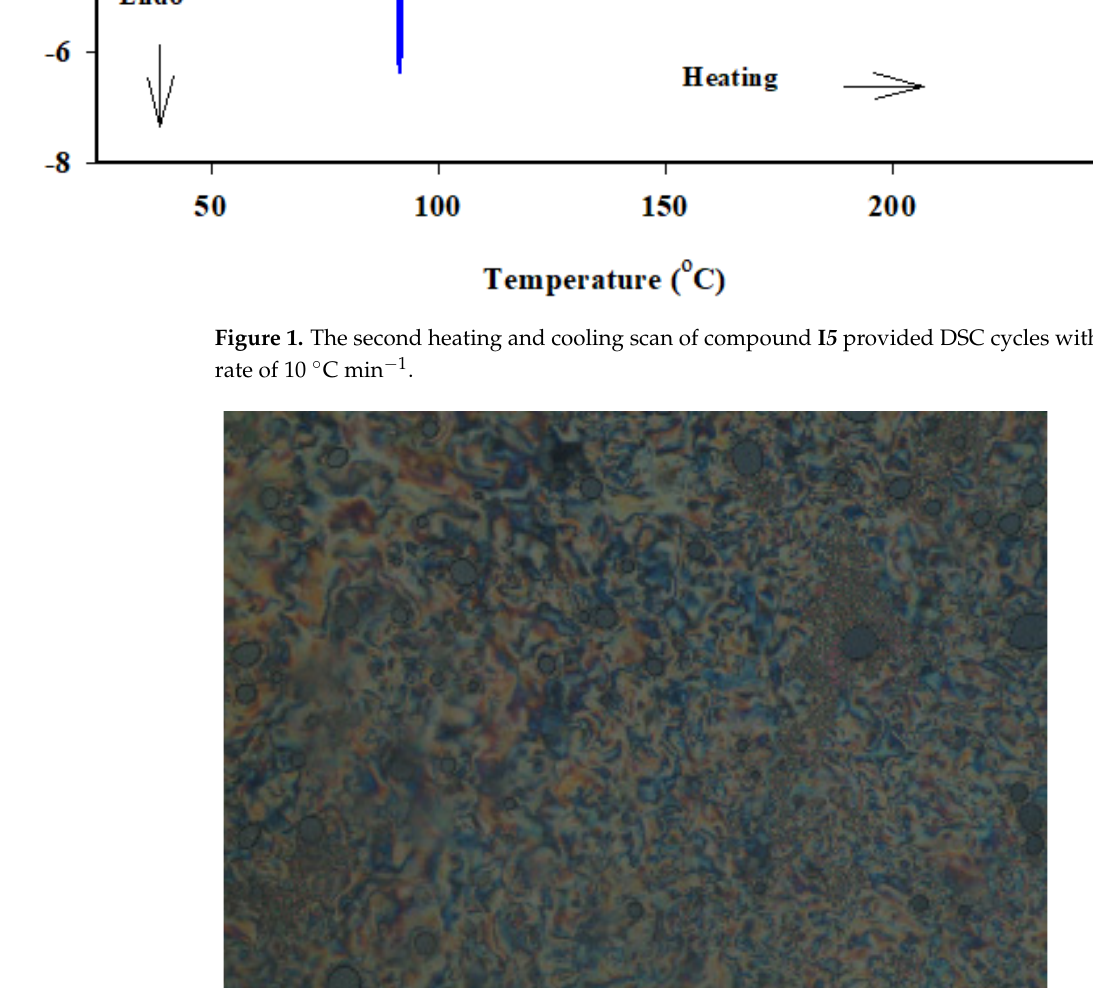
Figure 2. Texture of N phase observed under POM for compound I 5 .